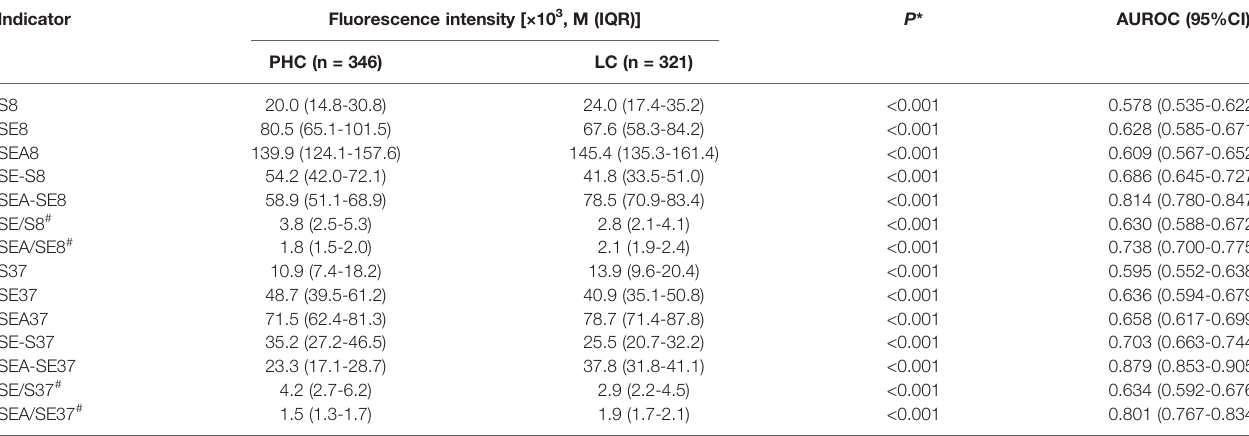
TABLE 2 | Aptamer-based triple serum fl uorescence intensities and their AUROCs for the diagnosis of PHC.